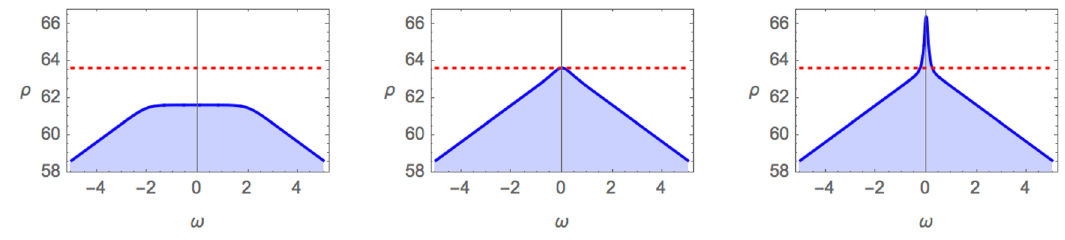
, ∆ = 1 , and UV cutoff 2 10